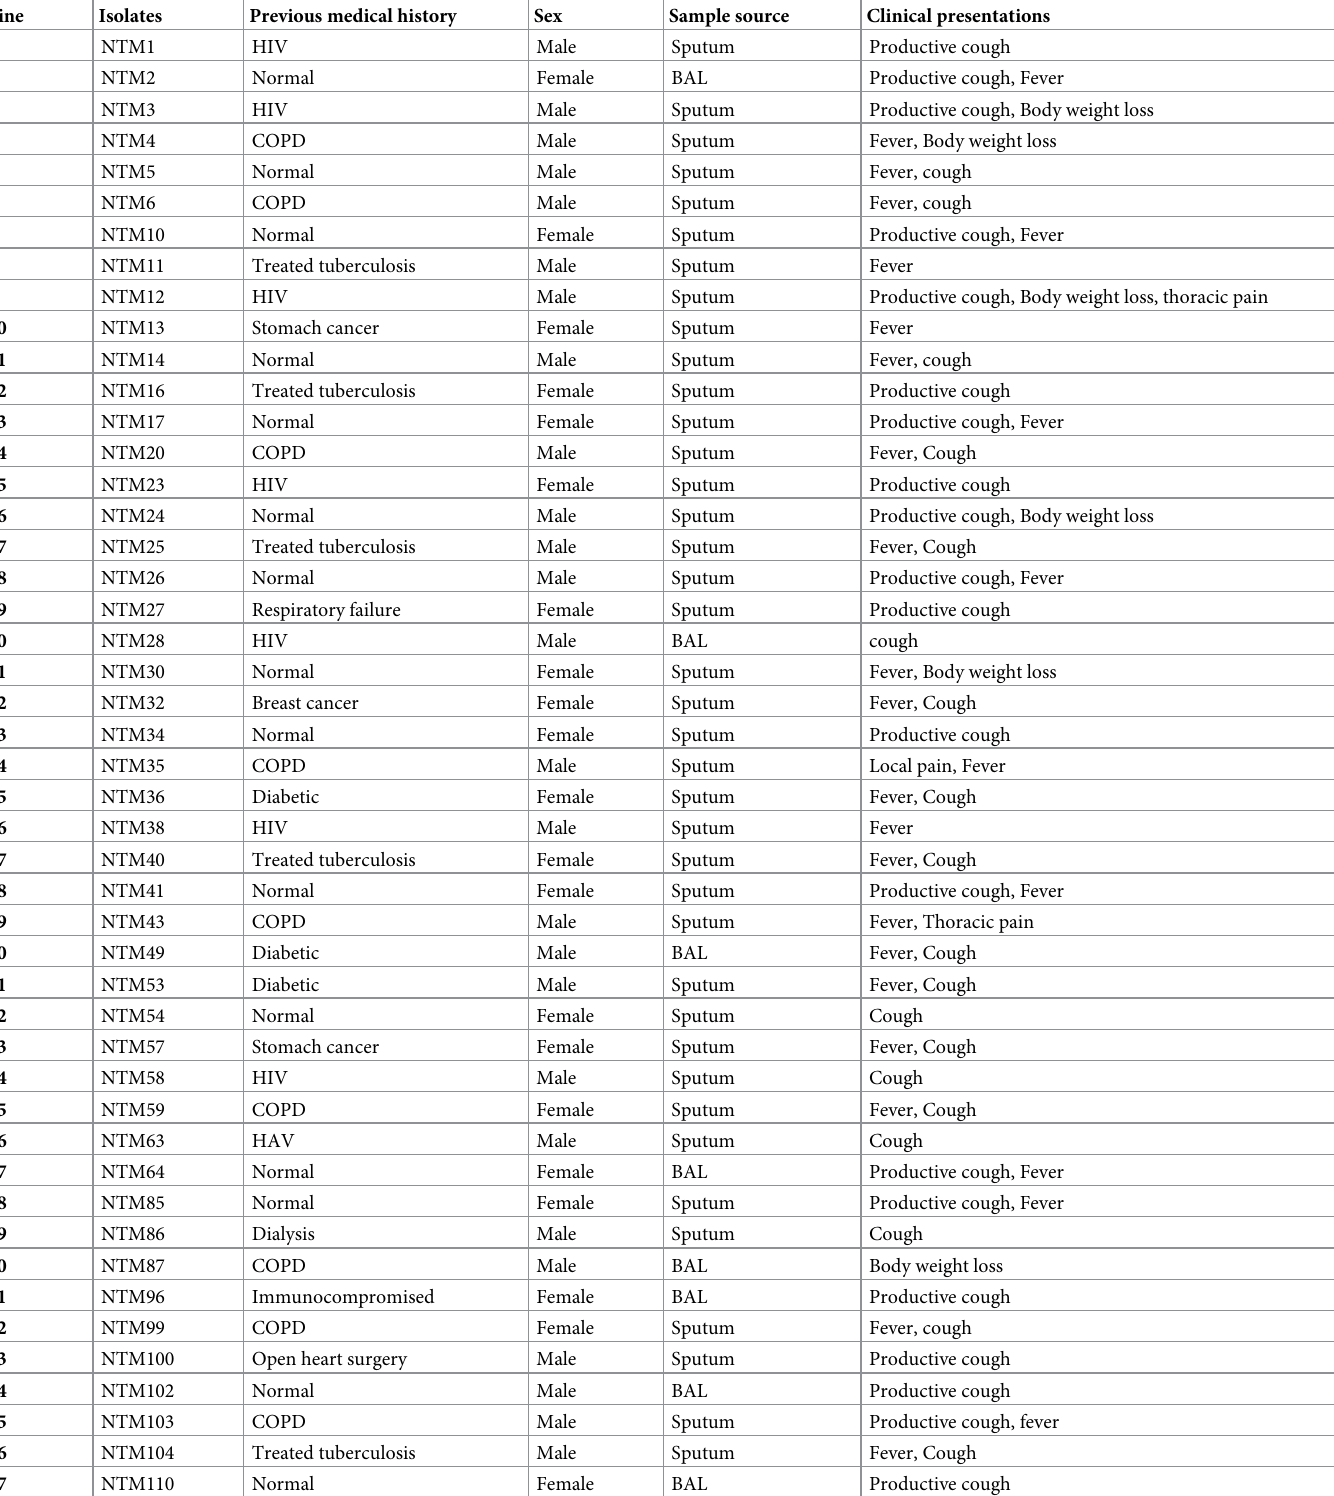
Table 1. Clinical details of the patients with NTM-Positive